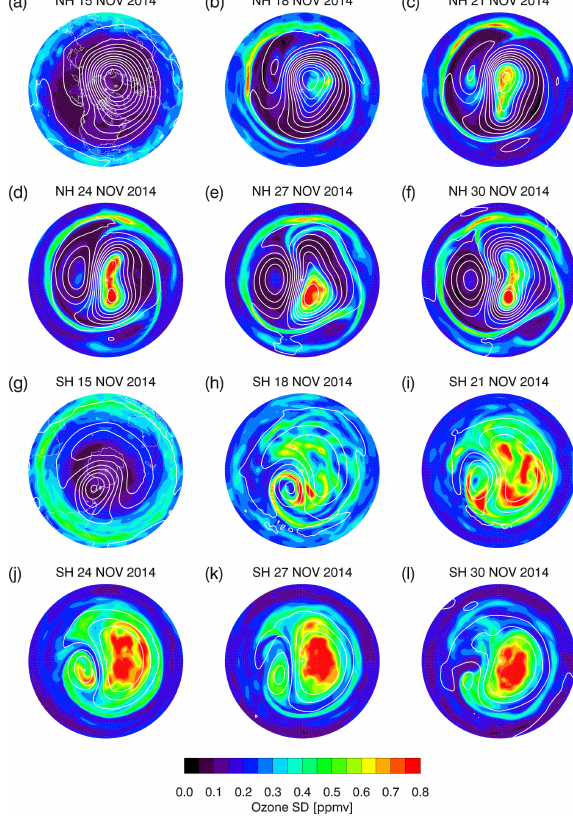
Figure 11. Maps of ozone σ ens (ppmv) (colors) at 10.5hPa ( ∼ 32km) overlaid with geopotential height (white lines) at 200m intervals for 15, 18, 21, 24, 27, and 30 November 2014 (all at 00:00Z). Panels (a–f) are NH and (g–l) are SH. Red (blue) con- tours indicated high (low) ozone values. Continent lines are placed on the maps for 15